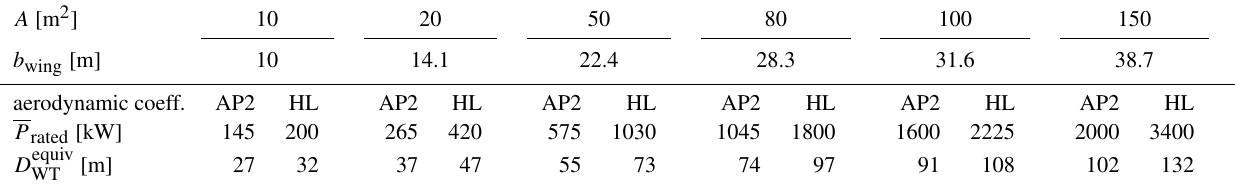
Figure 9. Representative power curves (a) for both sets of HL (circle) and AP2 (square) reference aerodynamic coefficients for both onshore (blue) and offshore (orange) locations. The masses of the A = 50m 2 wing area aircraft are scaled according to Eqs. (6) and (7) with a mass exponent of κ = 2 . 7. Average cycle power P is derived from p5, p50, p95 wind velocity profiles within each of the k = 10 WRF-simulated clusters. Diagram (b) presents the average annual wind speed probability distribution over reference height range of 100 ≤ z ref ≤ 400m. The annual energy production distributions over the wind speed are depicted in (c) . Diagram (d) shows the corresponding harvesting factor ζ . Table 2. Rated power (cycle average) of AWESs with a mass scaling exponent of κ = 2 . 7 and equivalent wind turbine rotor